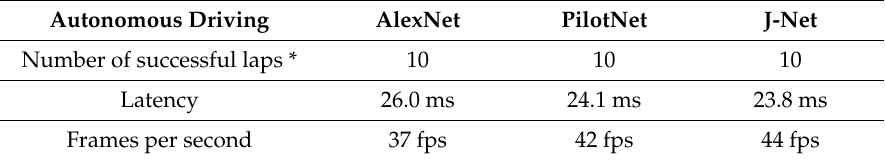
Table 5. Quantitative performance evaluation of autonomous driving using AlexNet, PilotNet, and J-Net on a high-performance platform used for the simulator